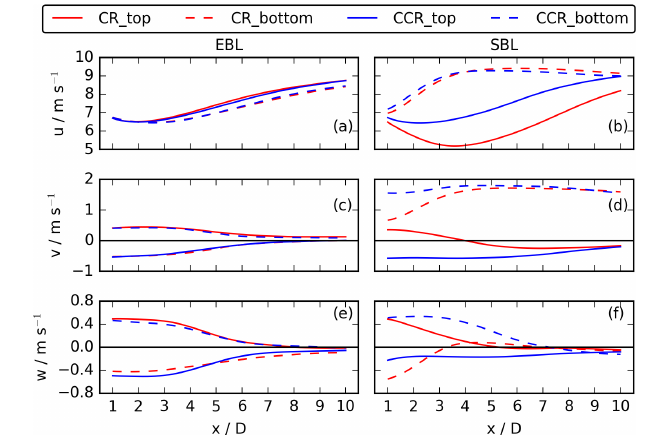
Figure 13. Sector and time averages of u , v , and w for the EBL wind-turbine simulations (a, c, e) and the SBL wind-turbine simu- lations (b, d, f) . u and v show the top and bottom 90 ◦ sectors and w the southern (solid line) and northern (dashed line)